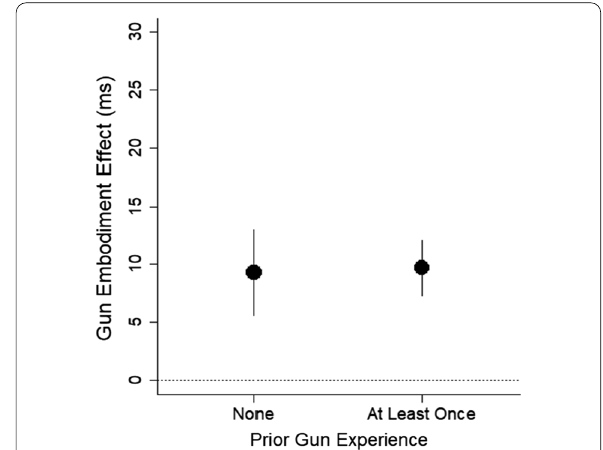
Fig. 14 Mean gun embodiment scores as a function of gun ownership and gun gaming status. The dashed line at 0 represents no